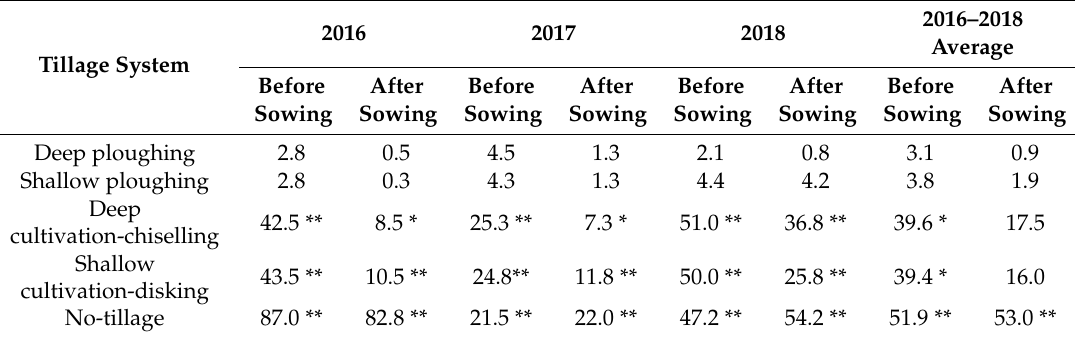
Table 2. The e ff ect of the tillage systems on the content of precrop residues (%) on the